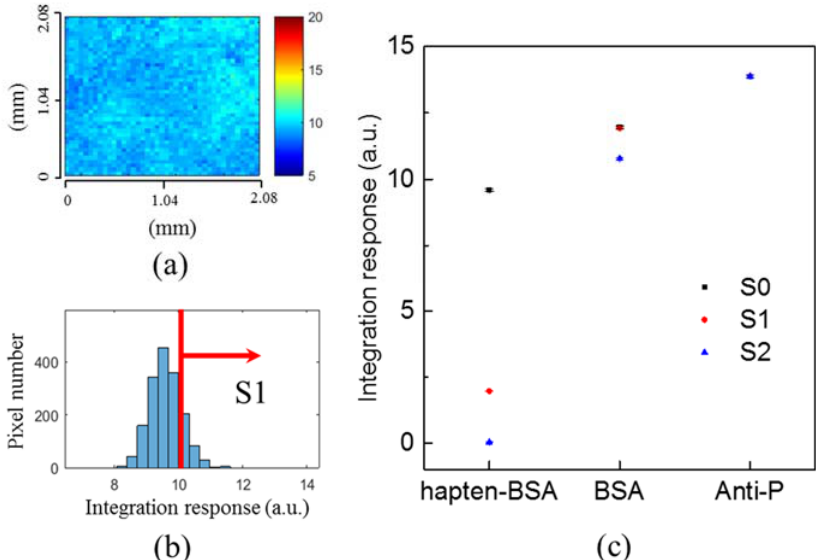
Figure 7. ( a ) SPR image of the hapten-BSA. ( b ) The histogram of the SPR image pixels. The red line shows the threshold value for the analysis. ( c ) The processed signals for S0 (without threshold process), S1 (with one threshold value) and S2 (with twice threshold values) for hapten-BSA, BSA blocking and anti-P images. The error bar was obtained from three measurements.